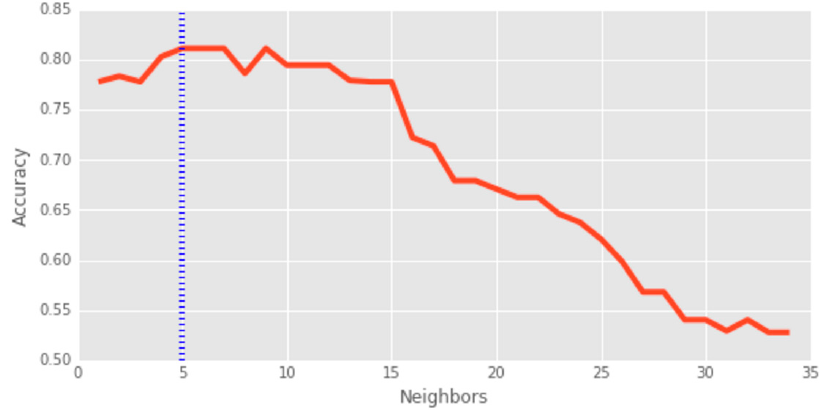
Figure 10. The accuracy of K-Nearest Neighbour (KNN) method to classify the geometry type of trajectories.